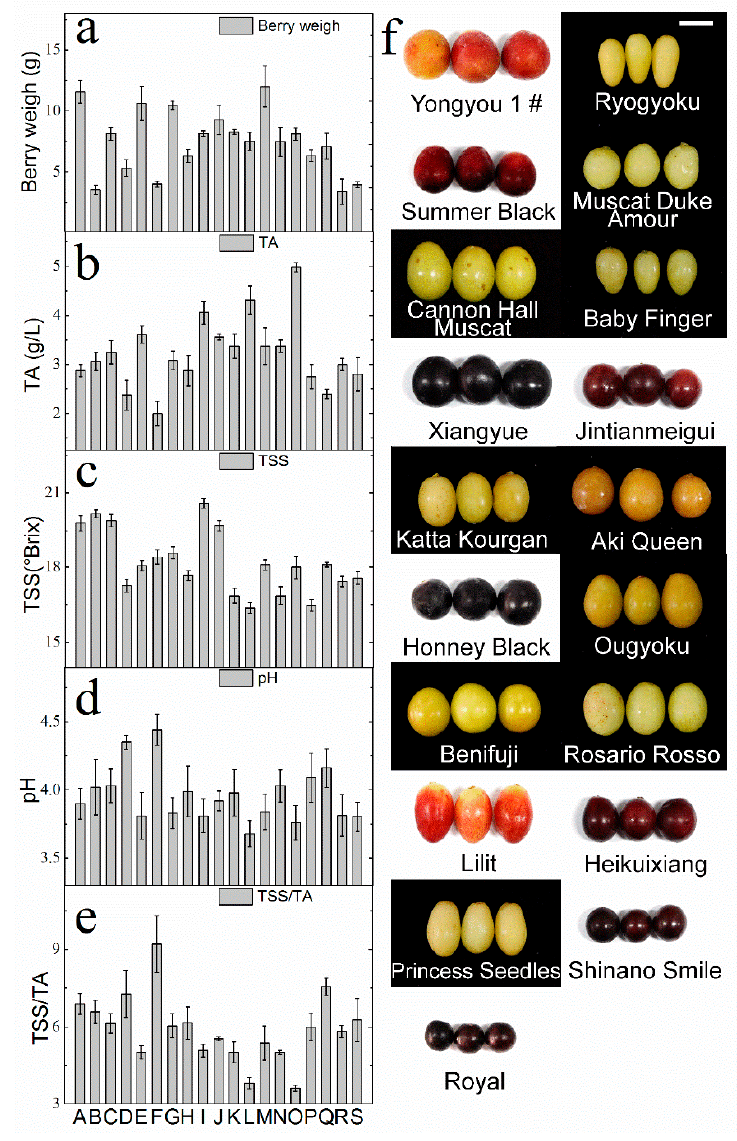
Figure 1. The standard chemical indices of unfamiliar table-grape cultivars. ( a ) Berry weight, ( b ) titratable acidity (TA; g/L), ( c ) total soluble solids (TSS; °Brix), ( d ) pH, and ( e ) sugar:acid ratio (TSS/TA). The photographs ( f ) in the right panel show berries of various grape cultivars. The unfamiliar cultivars include A—Yongyou 1 #, B—Ryogyoku, C—Summer Black, D—Muscat